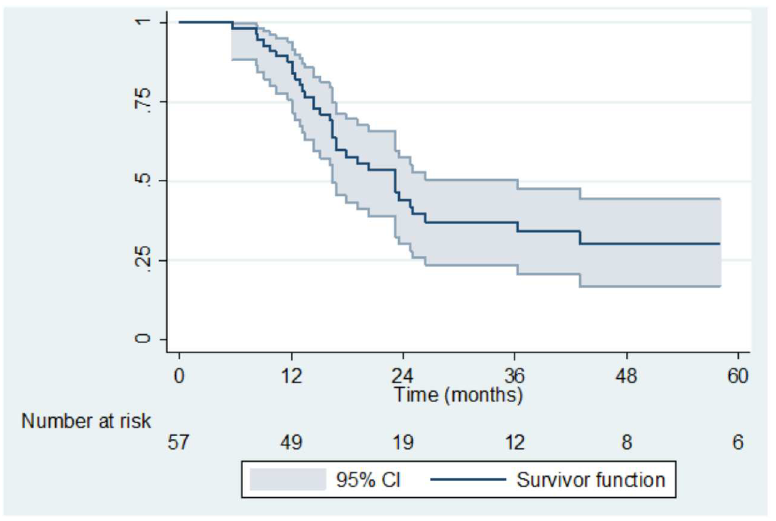
Fig 2. Metastasis Free